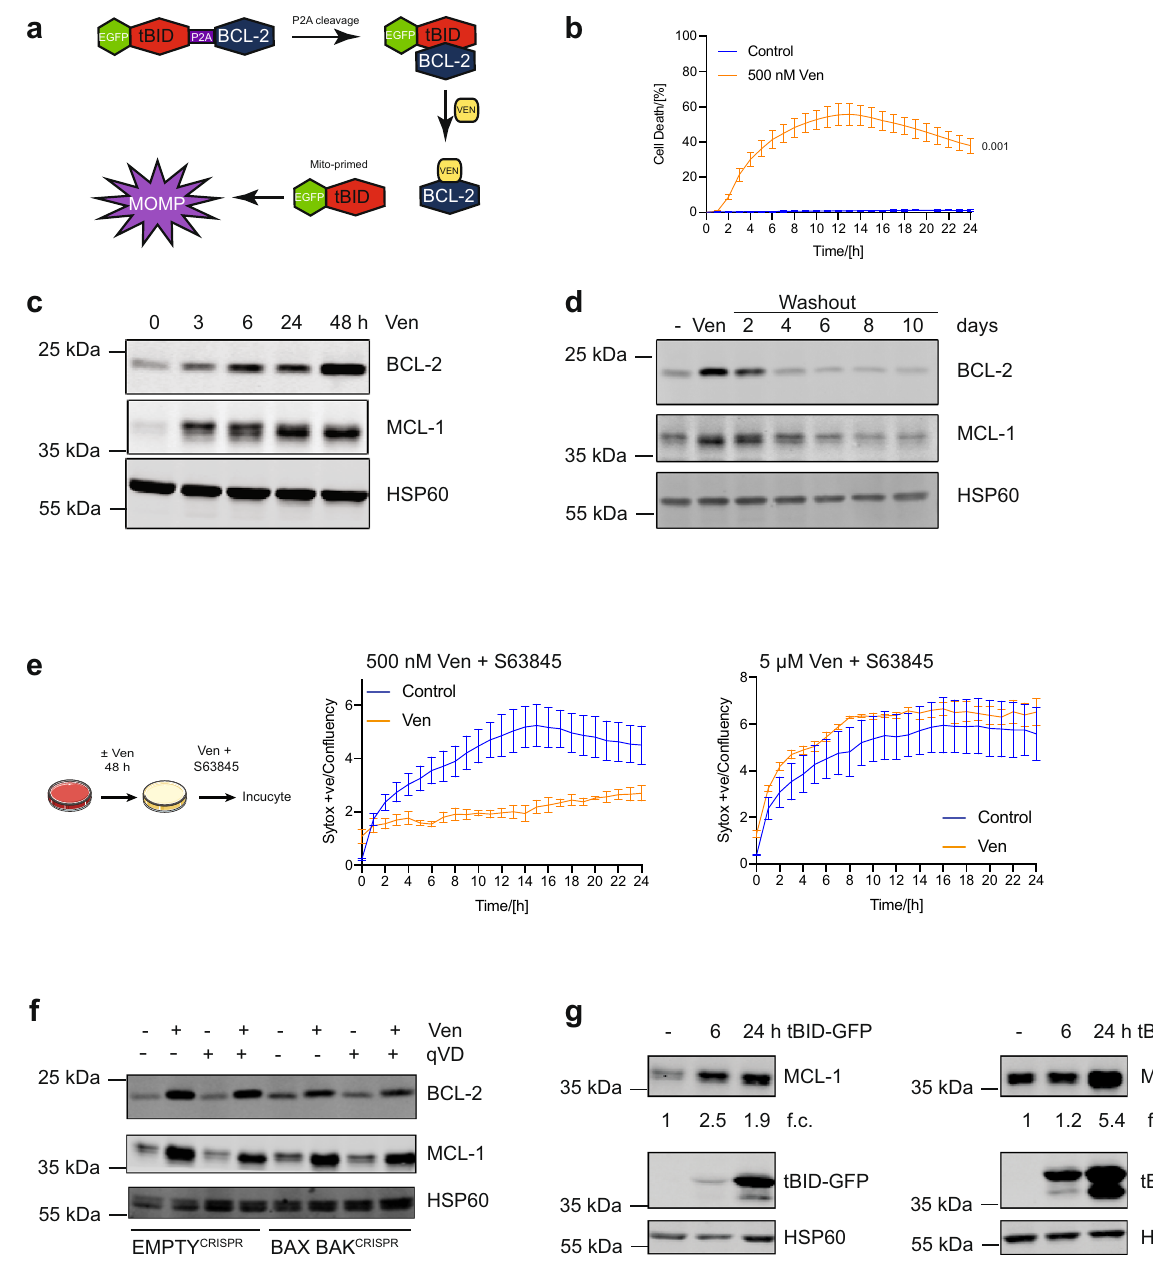
Fig. 1 BH3-mimetics and BH3-only proteins upregulate BCL-2 and MCL-1 causing apoptotic resistance. a Schematic model of the mitoprimed system. b HeLa tBID2A cells were treated with venetoclax (ven) and imaged over time. Percentage of dead cells was determined by staining all cells with Syto 21 and dead cells with propidium iodide. n = 3 independent experiments; mean values ± s.e.m.; unpaired, two-sided t -test at 24 h. c HeLa tBID2A cells were treated with 500 nM venetoclax, harvested at the indicated time points and protein expression was analysed by western blot (representative blot of three independent repeats). d HeLa tBID2A cells were treated for 48 h with 500 nM venetoclax followed by replacement with regular growth medium (washout). At the indicated times post medium change cells were harvested and protein expression was analysed by western blot (representative blot of three independent repeats). e HeLa tBID2A cells were treated with or without venetoclax as indicated for 48 h followed by treatment with venetoclax and the MCL-1 inhibitor S63845. Cell death was then monitored by Sytox Green staining and Incucyte imaging. n = 3 independent experiments; mean values ± s.e.m. f Control or BAX BAK CRISPR HeLa tBID2A cells were treated with 500 nM venetoclax in combination with 10 μ M qVD-OPh as indicated for 48 h, harvested and protein expression was analysed by western blot (representative blot of three independent repeats). g Control or BAX BAK CRISPR HeLa cells were transfected with tBID-GFP plasmid, harvested after the indicated times and protein expression was analysed by western blot. Fold change normalised to loading control is stated below (representative blot of three independent